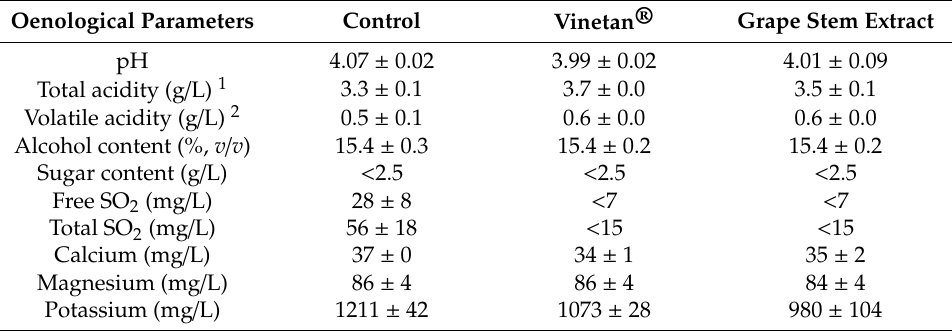
Table 2. Oenological parameters of all the wines under study before bottling (Mean ± SD). Oenological